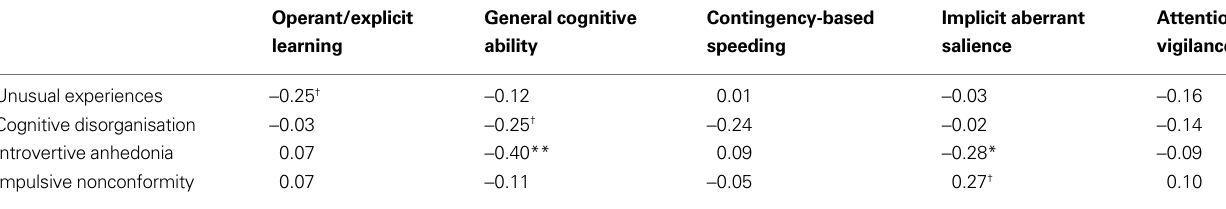
Table 3 | Correlations between factor scores and schizotypy subscales.